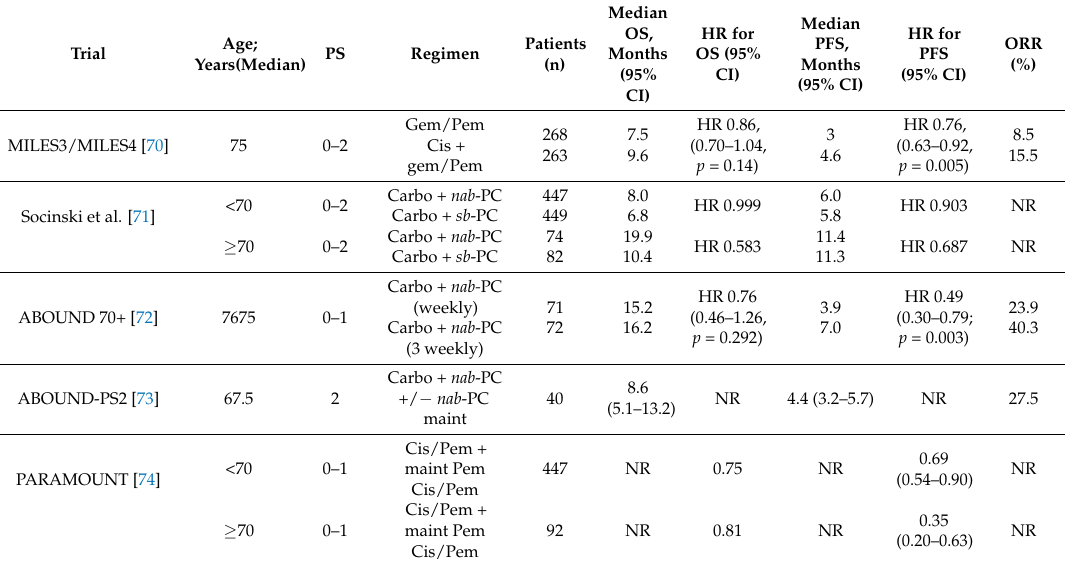
Table 4. Trials of 1st line chemotherapy in elderly/PS2 patients with